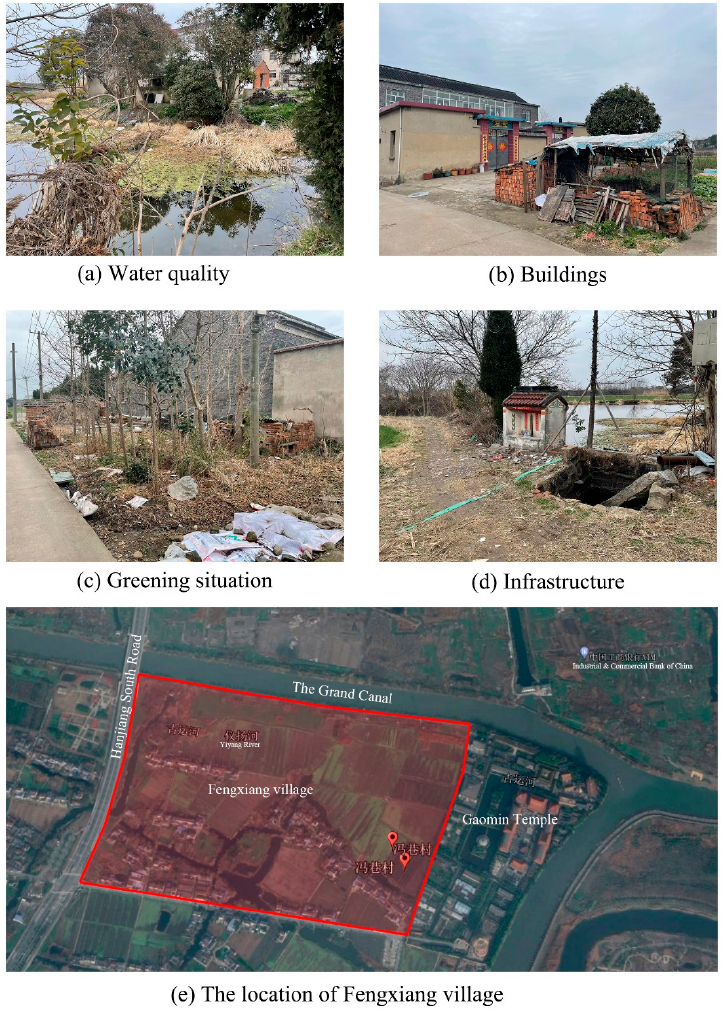
Figure 4. Current living environment situation in Fengxiang village.